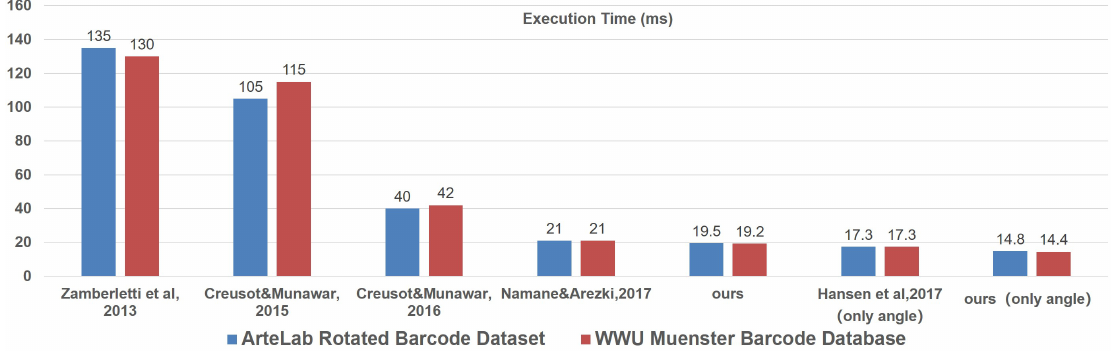
Figure 7. The different execution times for the two